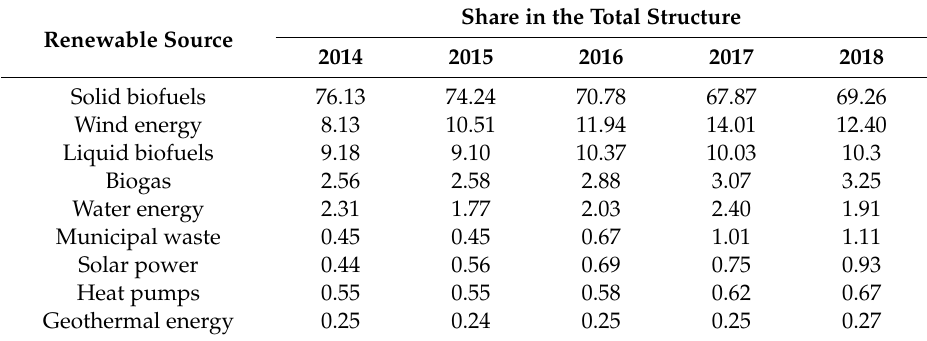
Table 1. Structure of obtaining energy from renewable sources in Poland by carriers 2014-2018.